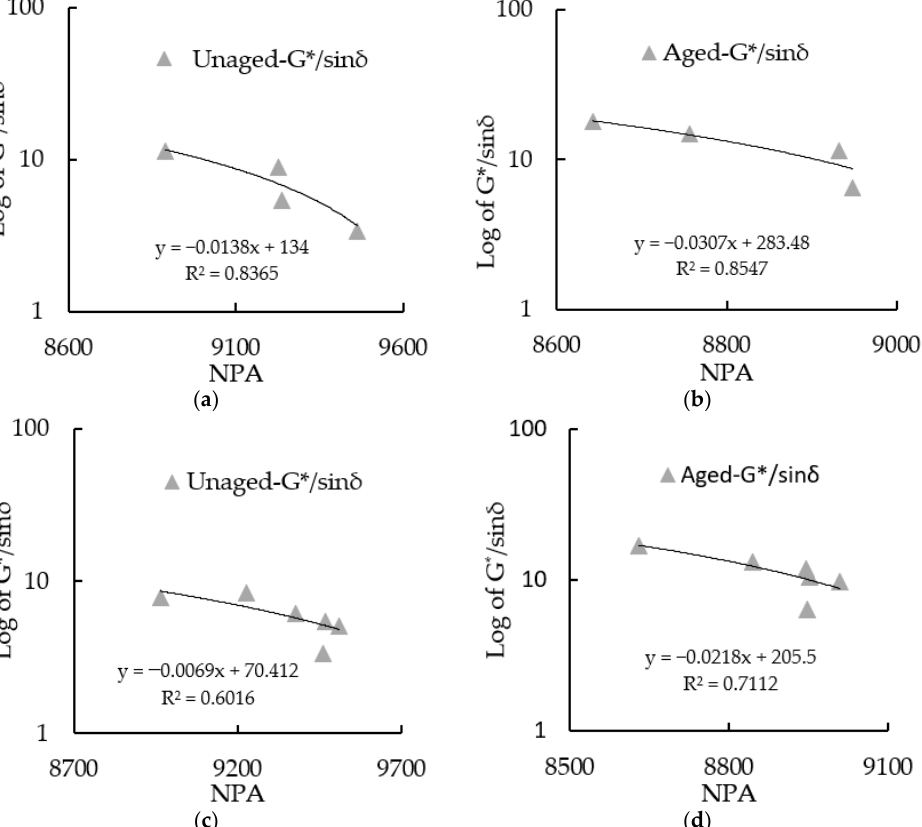
Figure 11. The linear relationship between G*/sin ( δ ) and NPA. ( a ) G*/sin ( δ ) and NPA of unaged SBS asphalt binders; ( b ) G*/sin ( δ ) and NPA of aged SBS asphalt binders; ( c ) G*/sin ( δ ) and NPA of unaged CRM asphalt binders; ( d ) G*/sin ( δ ) and NPA of aged CRM asphalt binders.